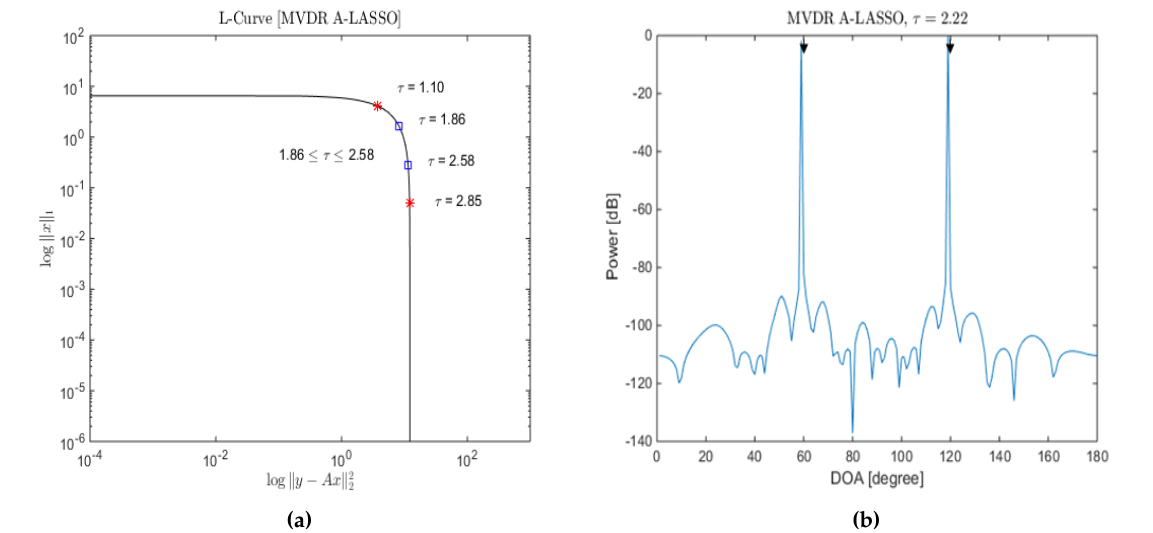
Figure 3. ( a ) The data residual (cid:107) y − Φ ∗ ¯ s (cid:107) 2 versus the solution (cid:96) 1 -norm linear scale on a log-log scale 2 (L-curve); ( b ) DOA estimation for two source signals; τ was selected using L-curve, in the MVDR A-LASSO problem (SNR = 0